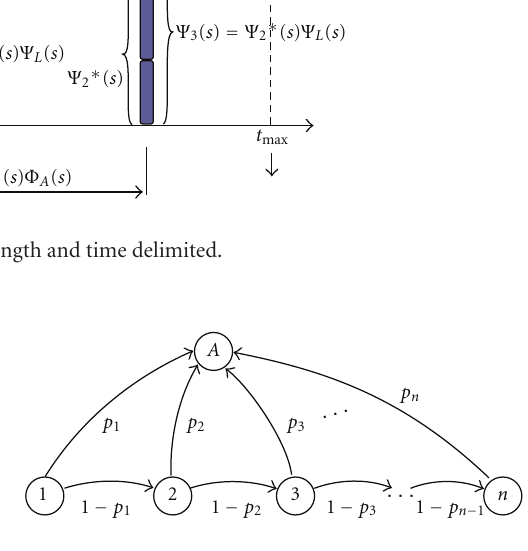
Figure 7: Markov chain model for hybrid burst